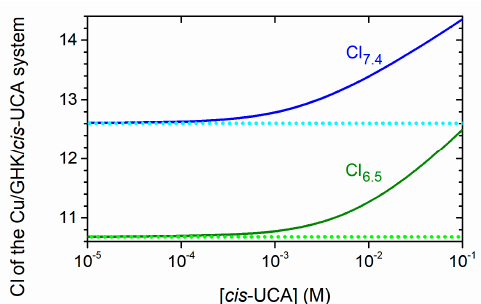
Figure 6. Influence of variable concentrations of cis -UCA on the apparent affinity of Cu/GHK/ cis -UCA system. Values of CI 7.4 and CI 6.5 in the presence of cis -UCA (blue and green solid line) are valid for [Cu] = [GHK] = 1 µM, at pH 7.4 and 6.5, respectively. The dotted lines represent the reference CI 7.4 and CI 6.5 levels calculated for solutions without cis -UCA.